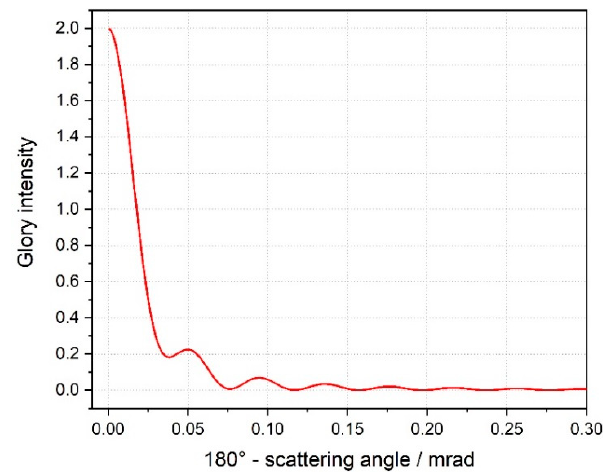
Figure 17. Intensity of the glory as predicted in [17] (with C1 = 0, C2 = 1).